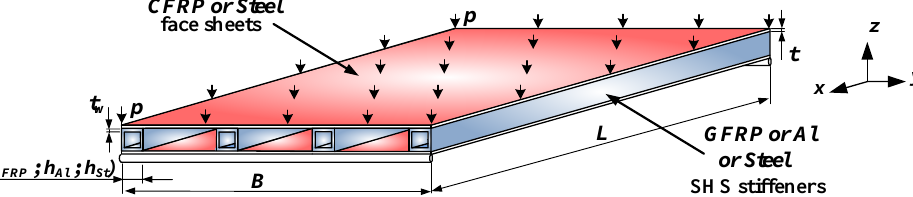
Figure 1. Investigated multicellular plate structure.